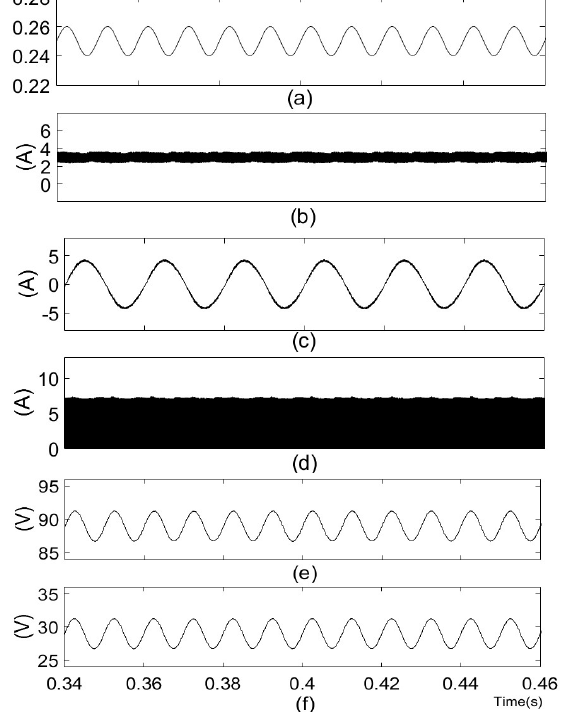
Figure 6. Simulation results of d ( a ), i L ( f ) with the RVCMS.